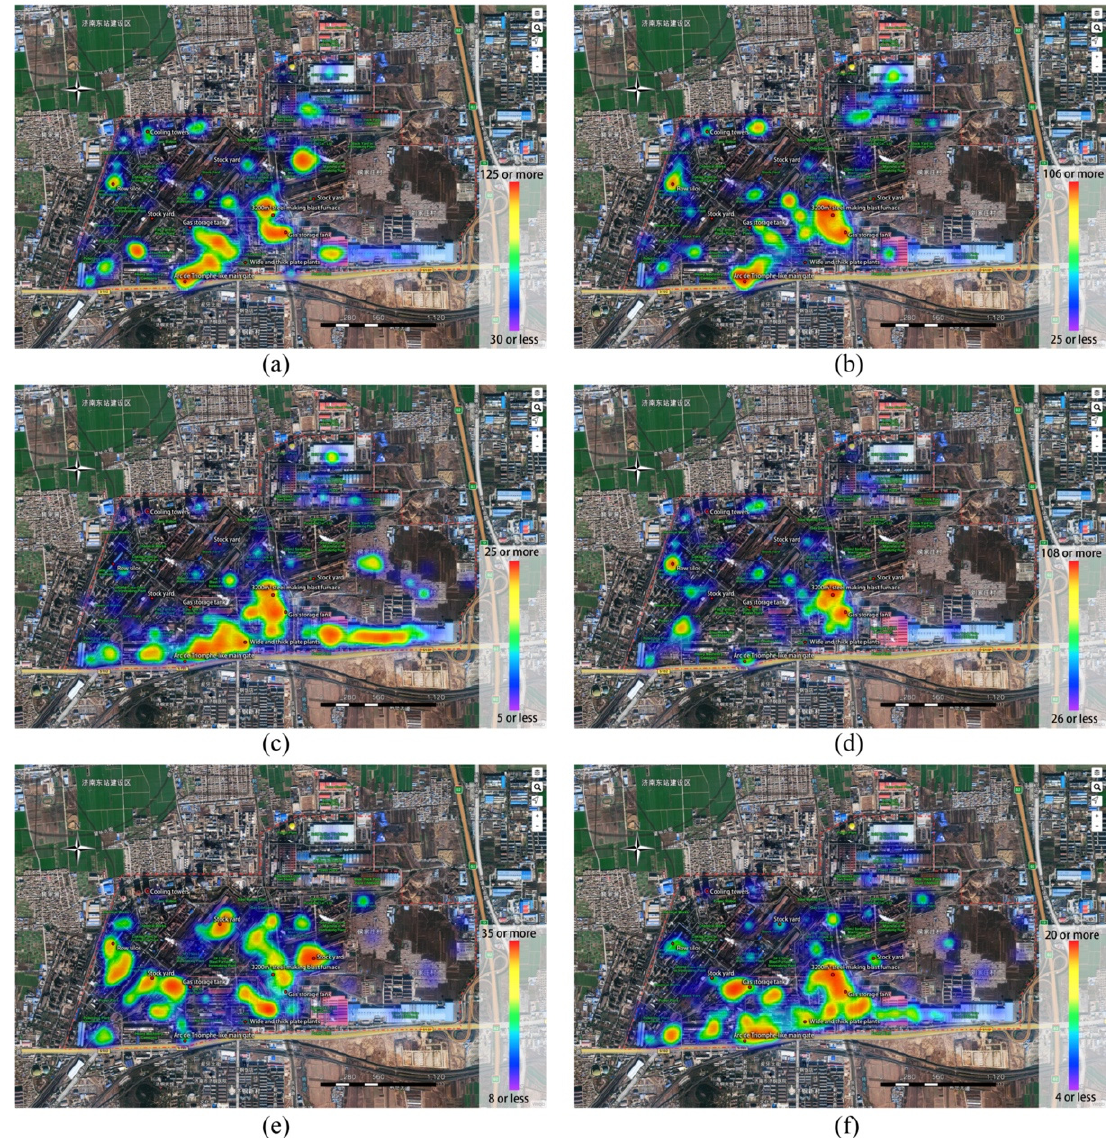
Figure 3. The hotspot distribution map of landscape values in the site: ( a ) Historical value; ( b ) cultural value; ( c ) social value; ( d ) aesthetic value; ( e ) environmental value; and ( f ) leisure value. (The basemap is made based on Mapbox Map Service China Edition, and Chinese can be ignored.)